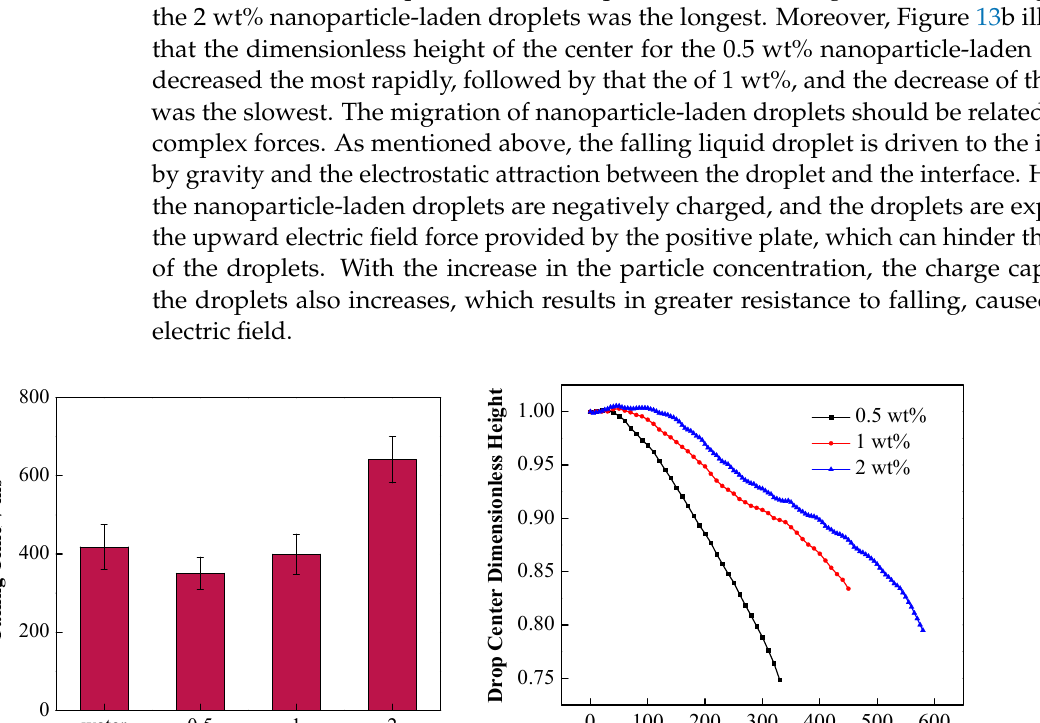
Figure 13. Effect of NP concentration on the migration of falling droplet. ( a ) The time of the droplet center falling to the interface under different particle concentrations; ( b ) effect of NP concentration on the dimensionless droplet center height. Figure 14. Rising process of secondary droplet in a DC electric field.